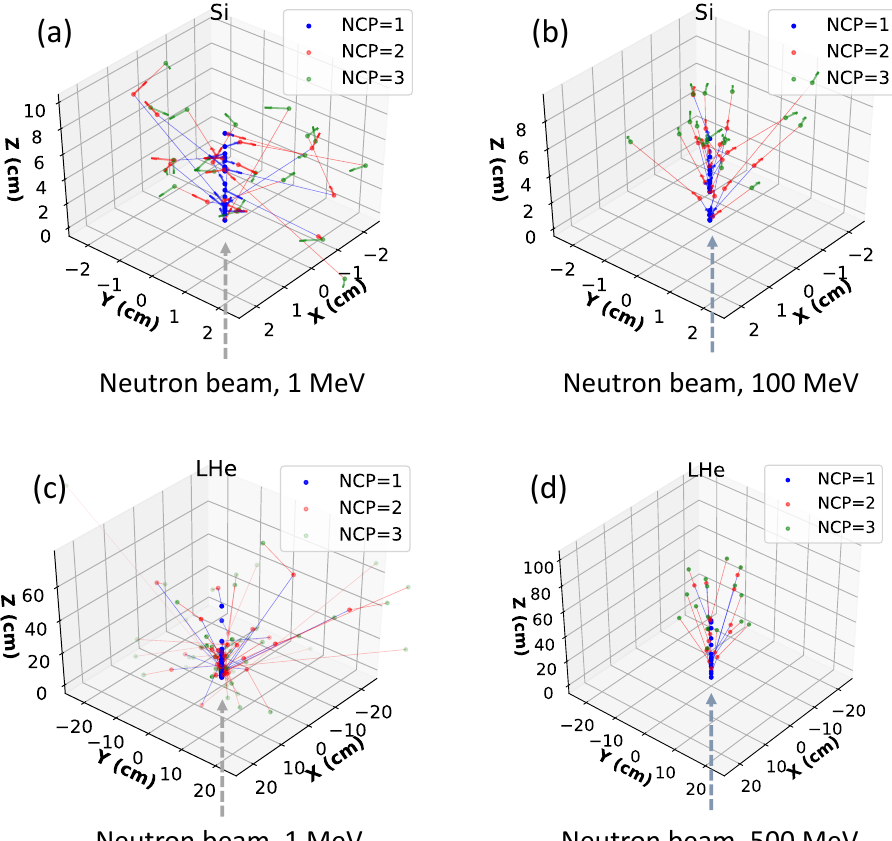
Figure 2. The scattering plots. “NCP” means the number of collisions in history. Blue points are the vertex A (the first collision), red points are the vertex B (the second collision), and green points are the vertex C (the third collision). The arrows are the velocity direction. ( a ) 1 MeV neutron beam with the silicon target. ( b ) 100 MeV neutron beam with the silicon target. ( c ) 1 MeV neutron beam with the liquid helium target. ( d ) 500 MeV neutron beam with the liquid helium